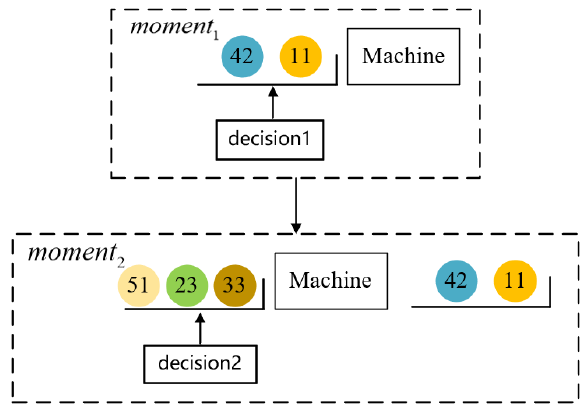
Figure 3. Determination of the scheduling